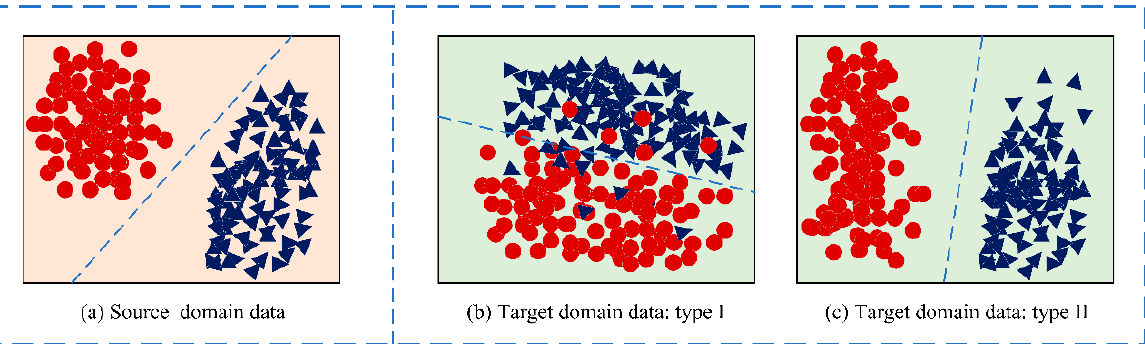
Figure 2. Target domain data with different data distribution.